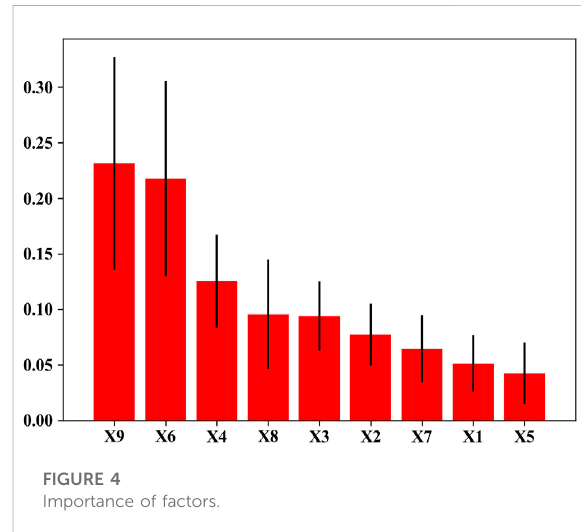
FIGURE 4 Importance of